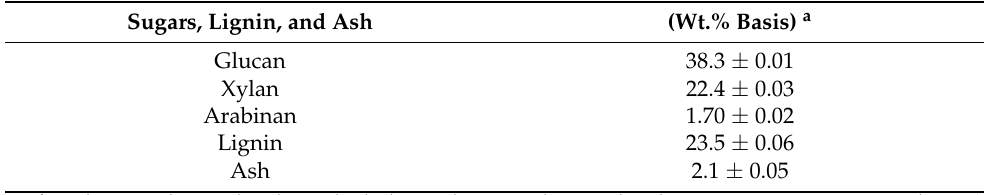
Table 1. Composition of sweet sorghum bagasse (SSB) on dry basis [22]. Sugars, Lignin, and Ash (Wt.% Basis) a